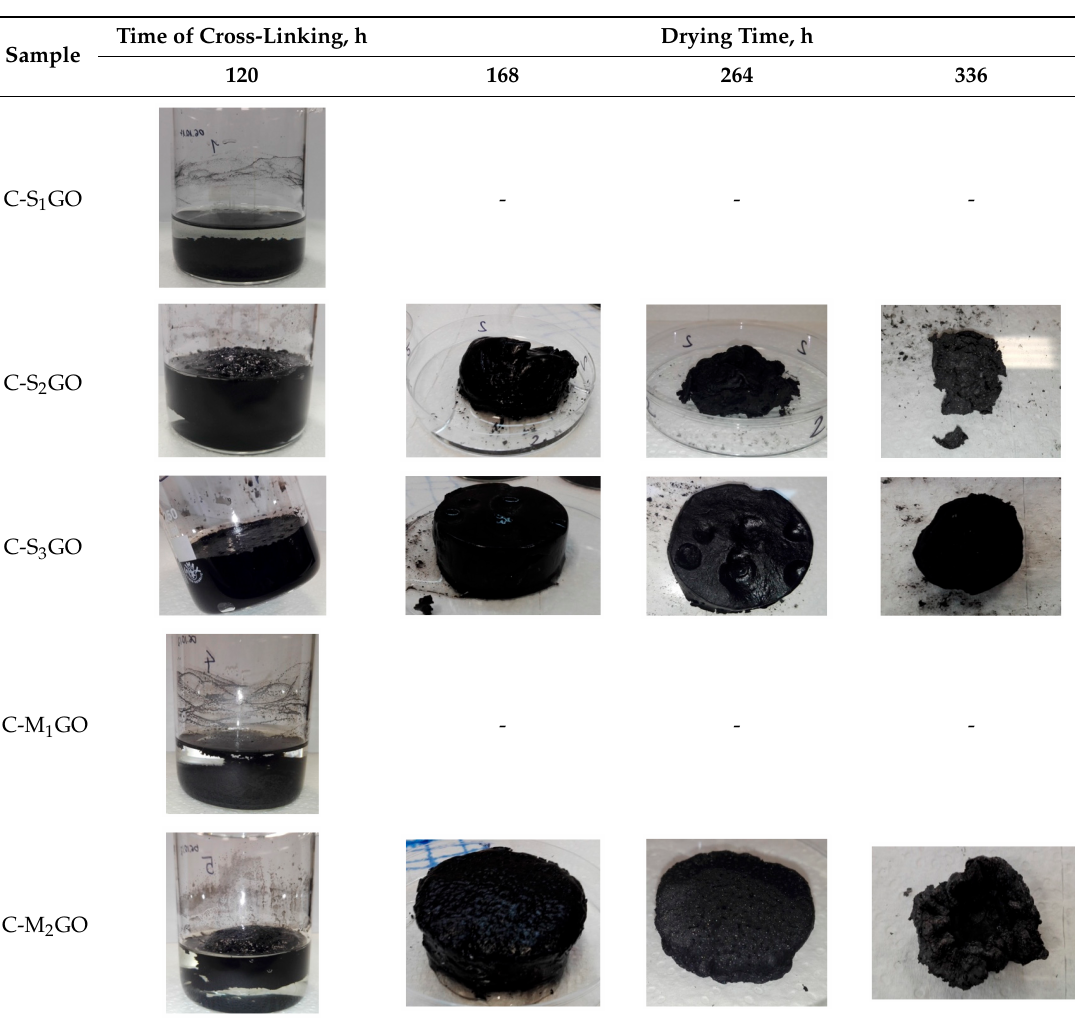
Table 3. Collection of macromorphology of graphene oxide powder samples treated with cross-linking process using